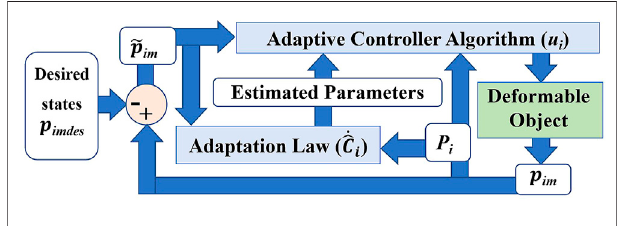
FIGURE 2 | Schematic diagram of the proposed adaptive control